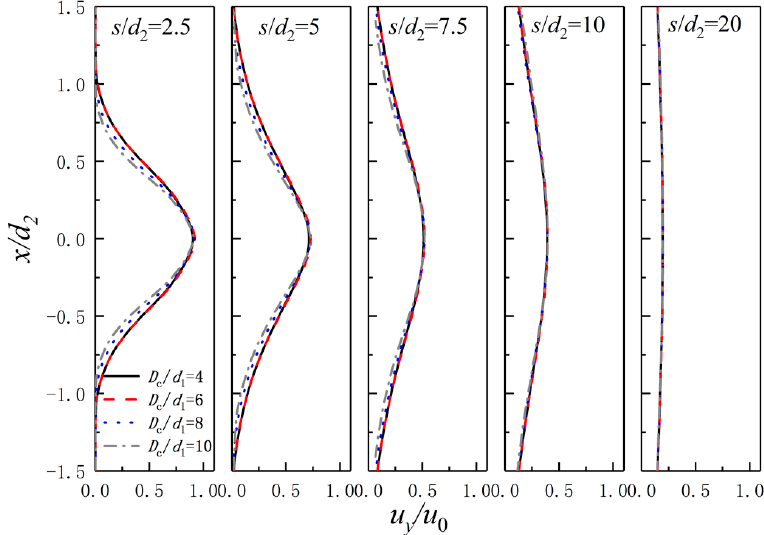
Figure 12. Velocity distribution of nozzles with different cavity diameters.